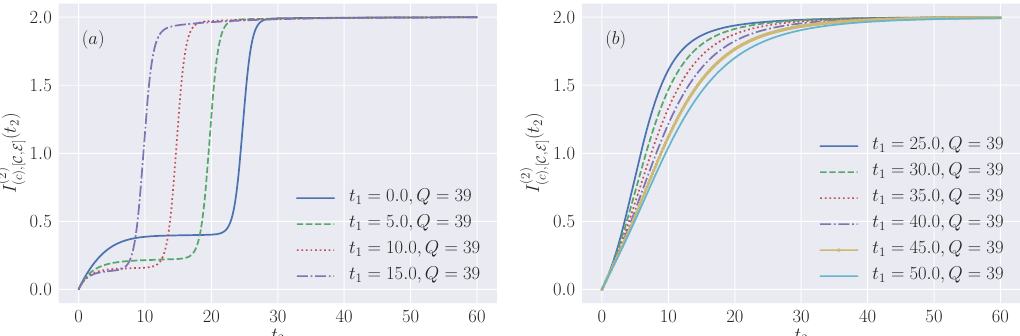
Figure 13 . Mutual information I (2) ( t 2 ) [de(cid:12)ned in eq. (4.7)] for the setting displayed in ( c ) ; [ C ; E ] (cid:12)gure 12. Sub(cid:12)gures ( a ) and ( b ) show the mutual information for initial charge Q = 39 and increasing values of t 1 , respectively smaller and larger than the Page time t p . For all plots, the evolution is driven by the RUC with a conserved U(1) charge de(cid:12)ned in section 3.2, where we set (cid:21) 1 = 1, (cid:21) 2 = 2 and N = 40 (while we chose d =